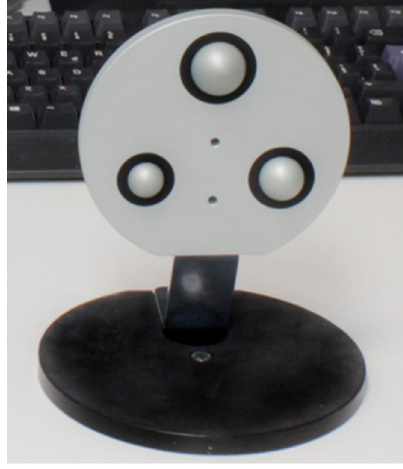
Figure 5. First reference artifact.